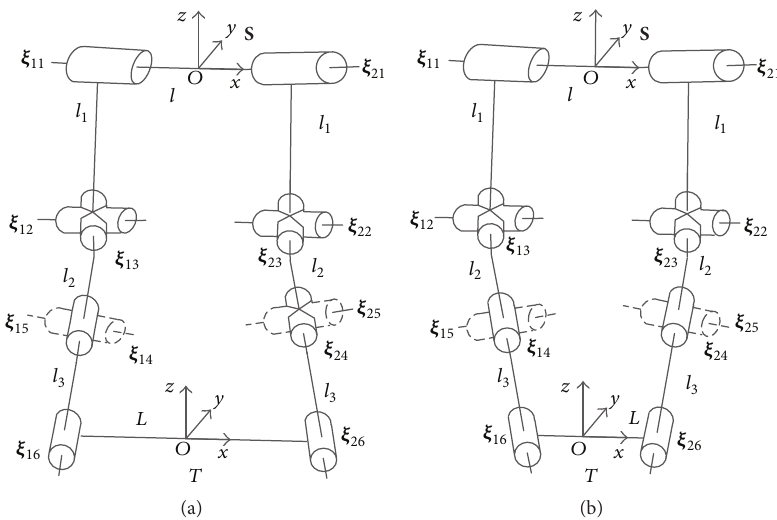
Figure 6: The mechanism of foot while grasping the ground passively. The distance between two endpoints of the digits 𝐿 > 𝑙 , while 𝜃 13 > 0 (relative to the configuration in Figure 3), 𝜃 23 = −𝜃 13 , 𝜃 𝑖𝑗 (𝑖 ̸= 1, 3, 𝑗 ̸= 3) = 0 in (a); 𝐿 < 𝑙 , 𝜃 13 < 0 (relative to the configuration in Figure 3), = −𝜃 𝜃 (𝑖 ̸= 1, 3, 𝑗 ̸= 3) = 0 in 𝜃 23 13 , 𝑖𝑗